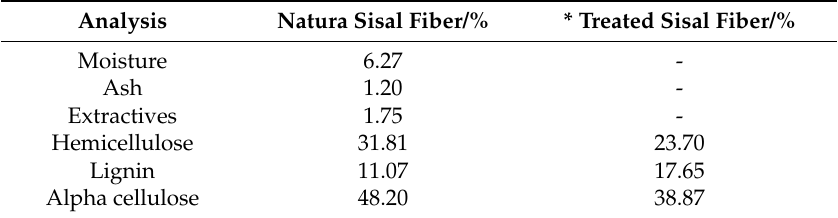
Table 3. Lignocellulosic composition of the sisal